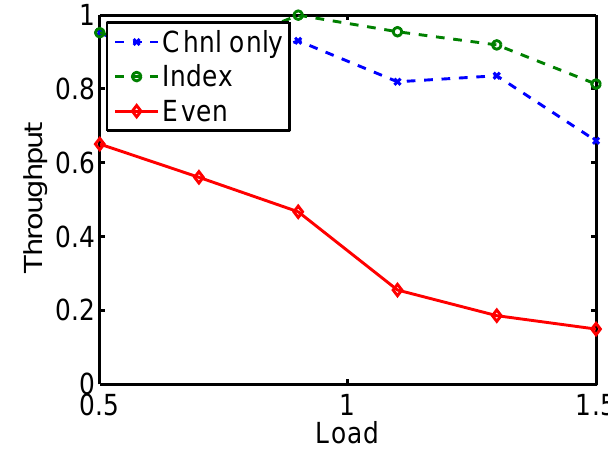
Figure 7. Percentage of Missed Deadline with Different Maximum File Size, Synthetic Trace